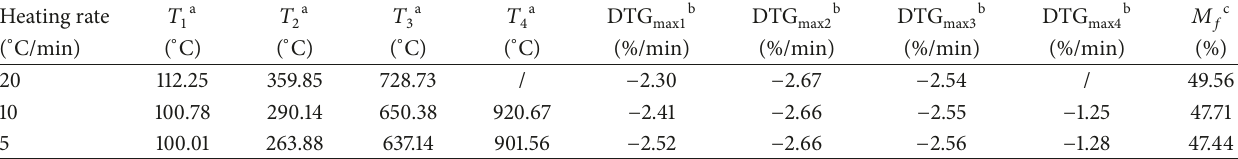
Table 3: Characteristic parameters for sediment pyrolysis at different heating rates.